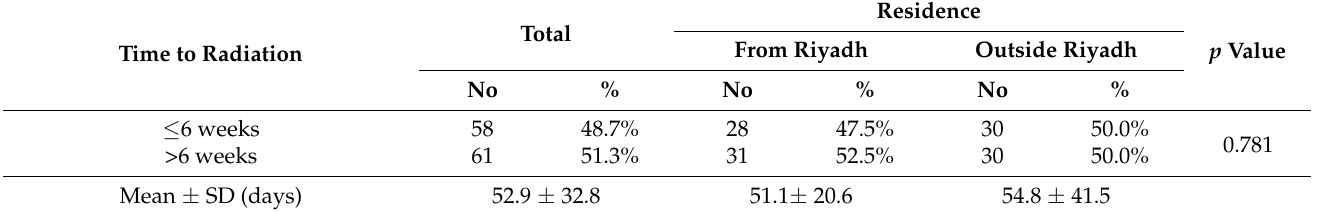
Table 5. Time to radiation in all patients, according to residence.